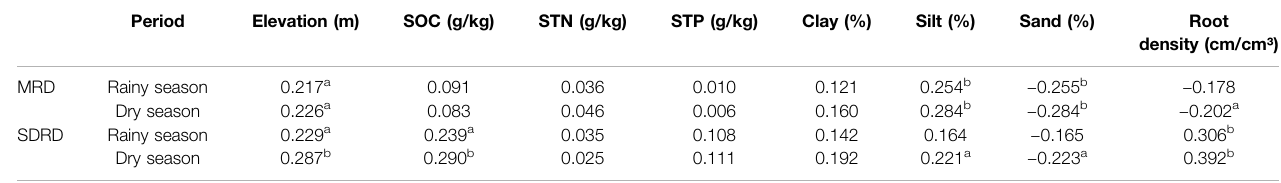
TABLE 4 | Pearson correlation between MRD, SDRD, and in fl uencing factors in rainy and dry seasons. Period